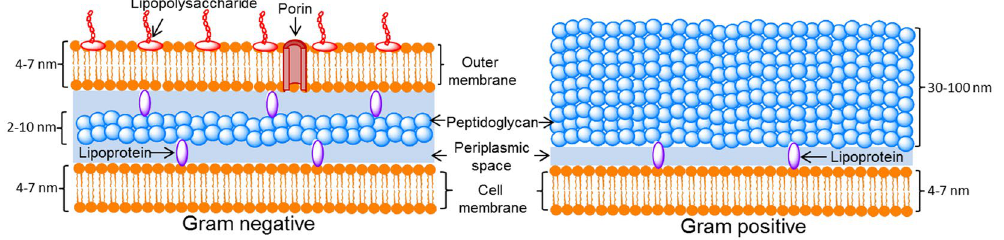
Figure 2. Cell wall structure for Gram negative and positive